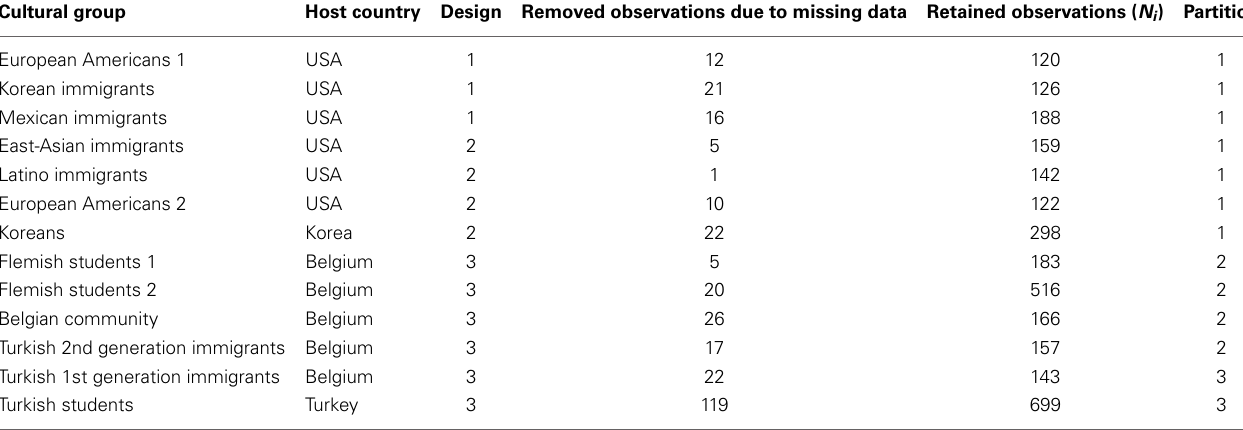
Table 1 | The 13 cultural groups under consideration and associated host country, design and sample size (note: each situation-subject combination counts as one